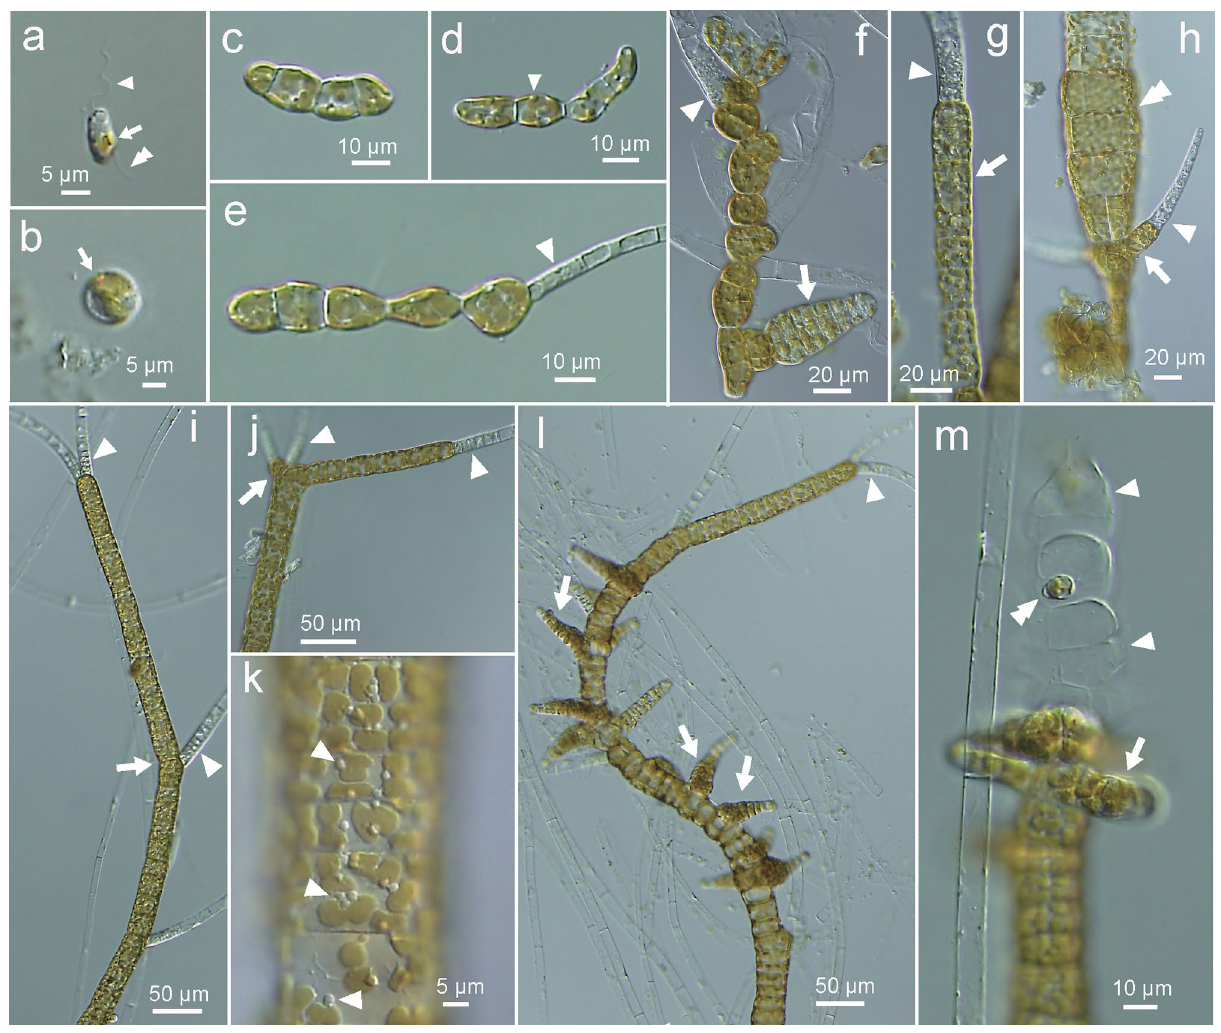
Figure 3. Zoospore, gametophytes and young sporophytes of Setoutiphycus delamareoides gen. & sp. nov.. ( a) Released zoospore. Arrowhead and double arrowhead show anterior and posterior flagella, respectively. Arrow shows stigma. ( b) Settled zoospore retaining stigma (arrow). ( c–e) Germlings. Arrowhead shows chloroplast with pyrenoid ( d ). Arrowhead shows phaeophycean hair ( e ). ( f) Gametophyte forming plurilocular zoidangium (arrow). Arrowhead shows phaeophycean hair. ( g) Young uniseriate sporophyte (arrow) with terminal hair (arrowhead). ( h) Young parenchymatous sporophyte (double arrowhead) forming lateral branchlet (arrow) with terminal hair (arrowhead) near the base. ( i) Young uniseriate sporophyte of sub-sympodial growth (arrow). Arrowheads show phaeophycean hairs. ( j) Initial of branch (arrow) on young sporophyte. Arrowhead shows phaeophycean hair. ( k) Surface view of sporophyte showing discoidal chloroplasts with projected pyrenoids (arrowheads). ( l) Mature sporophyte forming lateral, lanceolate plurilocular zoidangia (arrows). Arrowhead shows terminal phaeophycean hair. ( m) Plurilocular zoidangia formed at the tip of sporophyte. Arrow shows plurilocular zoidangia. Arrowheads show emplied plurilocular zoidangia. Double arrowhead shows in situ- germinated pluri-zoids. [Photographs by H. (ML, Fig. 4) and Bayesian (BI) analyses. The new alga nested in the clade composed of Trachynema, Delamarea, Cladothele , and Punctaria, supported by full bootstrap/posterior priority values (clade 1), although the supports for the nodes connecting the new alga with other genera were low. Clade 1 was sister to the clade of Striaria and Asperococcus, supported by full bootstrap/posterior priority values (clade 2). The statistical supports for the node connecting the new alga and Punctaria were low (51%) in ML and medium in BI (0.97) analyses. In the ML molecular phylogeny of the taxa comprising clade 1, clade 2 and several representative species of Punctaria based on the concatenated DNA sequences of mitochondrial cox 1, cox 3, nad 2, nad 5, nad 6 and chloroplast atp B, psa A, psb A and rbc L genes (Fig. 5; 10,975 bp), the new alga was sister to Cladothele and the clade comprised of the new alga and Cladothele was sister to the clade of Delamarea and Trachynema, although the statistical supports for the nodes were low (45 and 49%, respectively). On the other hand, in BI tree the new alga was sister to the clade of Punctaria spp., although the statistical supports were medium to low (0.94 p.p. in BI and < 70% in ML; Supplementary Information 5). Sequence divergences ( P -distance values) between the